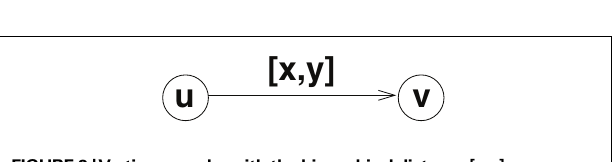
FIGURE 2 | Vertices u and v with the hierarchical distance [ x , y